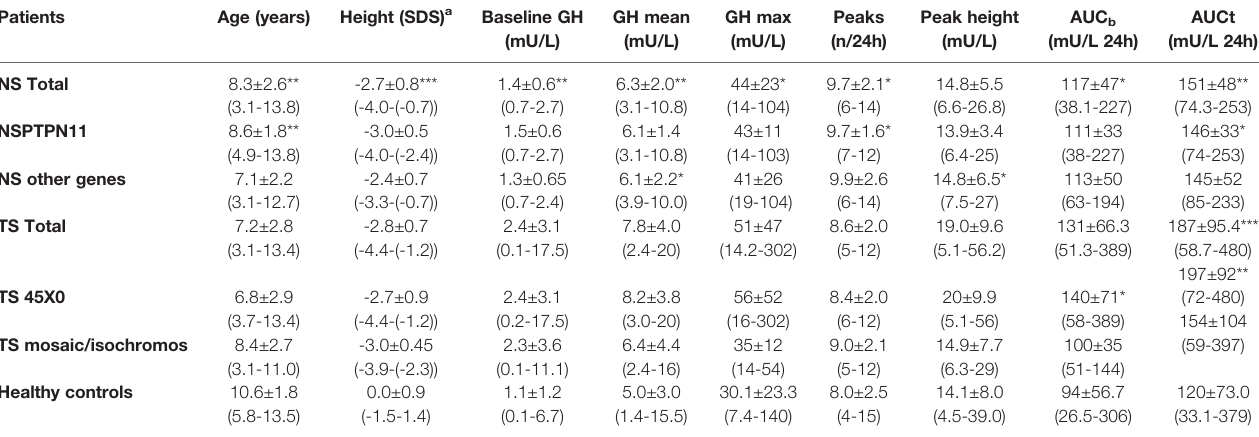
TABLE 1 | Auxological data and 24hour GH pro fi le measured with polyclonal antibodies in 25 with Noonan syndrome (NS) (with PTPN11 mutation (n=16, without n=9) and in 40 with Turner syndrome (TS) (XO in 31 and 9 either mosaicism or isochromosome), compared to children with normal height (n=45).